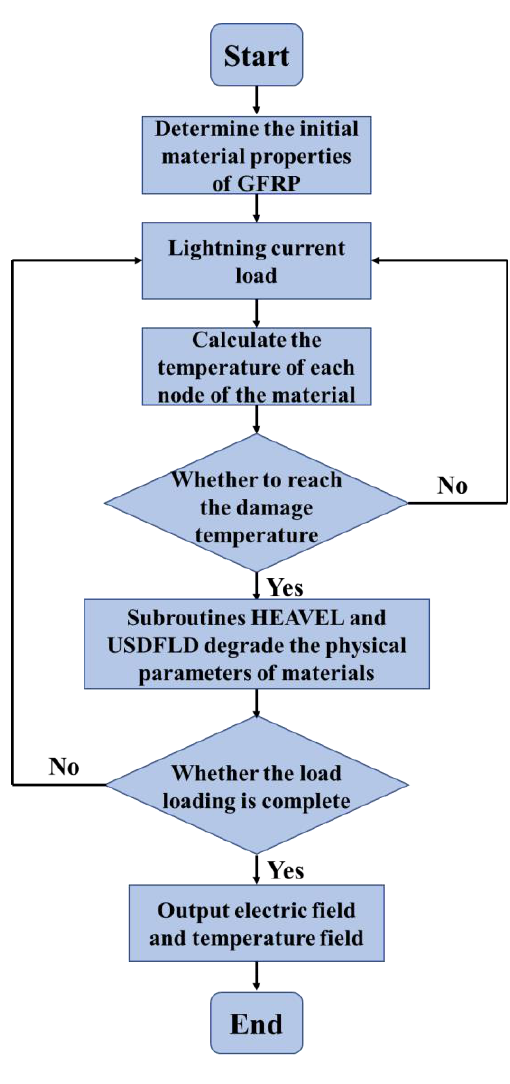
Figure 7. Electro-thermal coupling analysis flow chart.